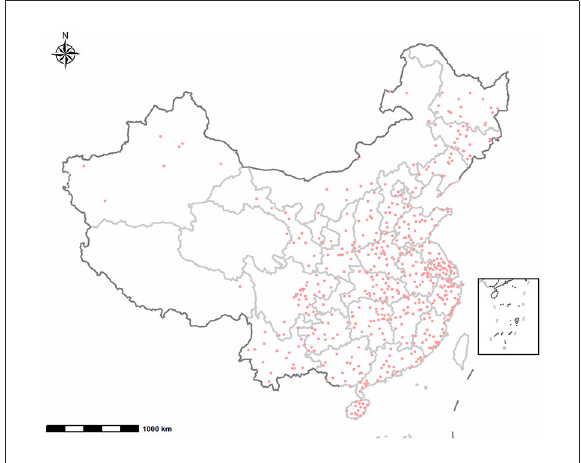
FIGURE1 Distribution of 551 participant cities in mainland